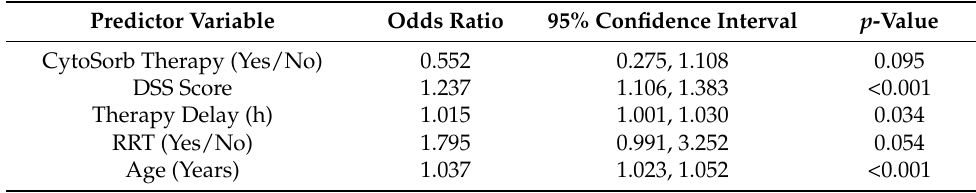
Table 7. Multivariate logistic regression results for predictors of day 56